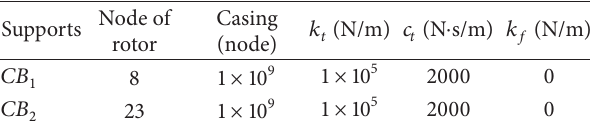
Table 7: Collection parameters of